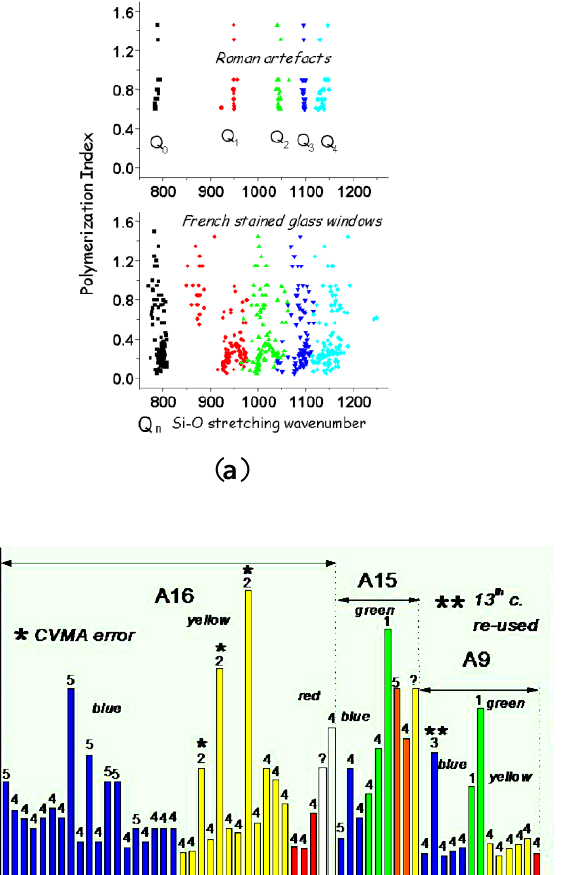
Figure 5. ( a ) The limited scattering of the Q stretching components of SiO tetrahedra n 4 indifferent Roman glass artifacts excavated in France, Italy, and Tunisia results from the controlled mass production using a single composition; on the other hand, the dispersed data measured for stained glass windows from Northern and Eastern France medieval churches arise from production by many different workshops [163]; ( b ) the absolute intensity of the Raman signal decreases with time because of the surface degradation of glass artifacts (leaching and microcracking); ( c ) the example given for Sainte-Chapelle (Paris) Rose window shows the easy differentiation by comparing as-recorded peak intensity between middle-aged and 19 th century restored pieces [156]: #5, 1 and 2-type glass pieces are restored pieces; #4-type pieces are original weathered stained glass pieces ; ( d ) examples of Raman spectra as-recorded on enameled artifact with a mobile Raman set- up: the signature of pigments (two Naples yellow glaze) and colored glaze (cobalt blue glaze) is recorded with a rather good intensity, when the signature of non-colored glass consists of tiny broad peaks on the complex background due to the Edge